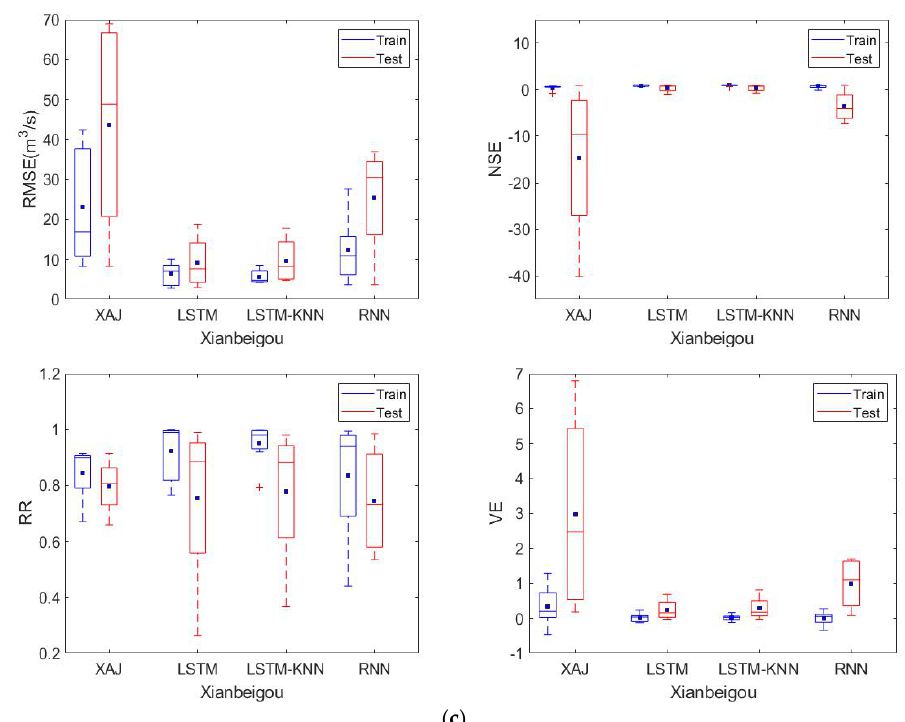
Figure 5 . Boxplots for four models (XAJ, LSTM, LSTM-KNN, and RNN) of RMSE, NSE, R 2 , and VE in Tunxi, Chenhe, and Xianbeigou Catchment. ( a ) Tunxi; ( b ) Chenhe; ( c ) Xianbeigou.